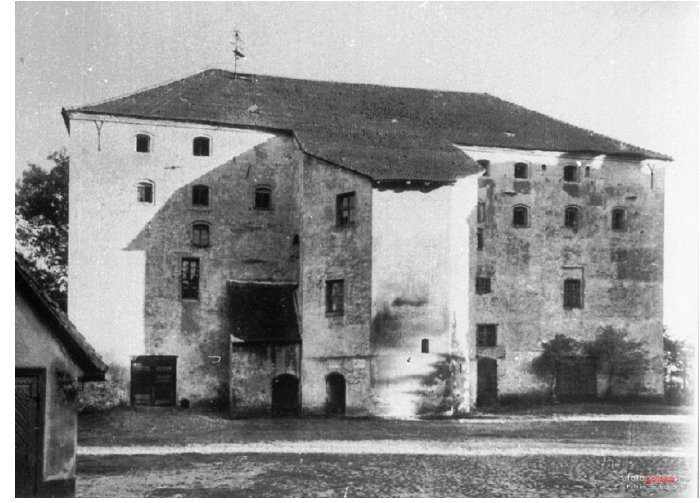
Figure 9. The Pomeranian Dukes’ Castle in the interwar period, source: fotopolska.eu.